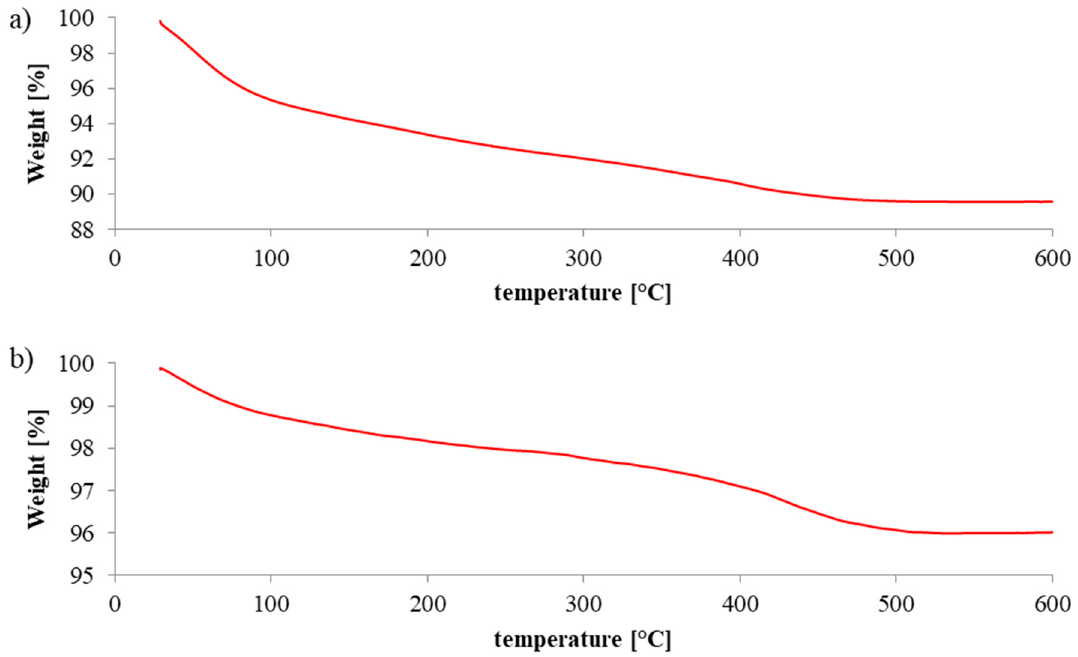
Figure 2. Thermograms of ( a ) 1%CuPc@TiO 2 (5 nm) ( b ) 1%CuPc@TiO 2 (15 nm).